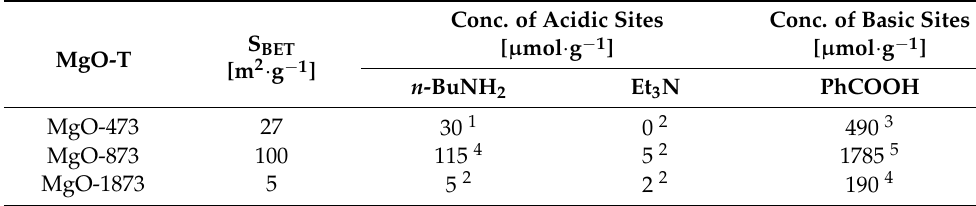
Table 2. The concentrations of acidic and basic sites on the surfaces of MgO-T samples (batch II fraction II).